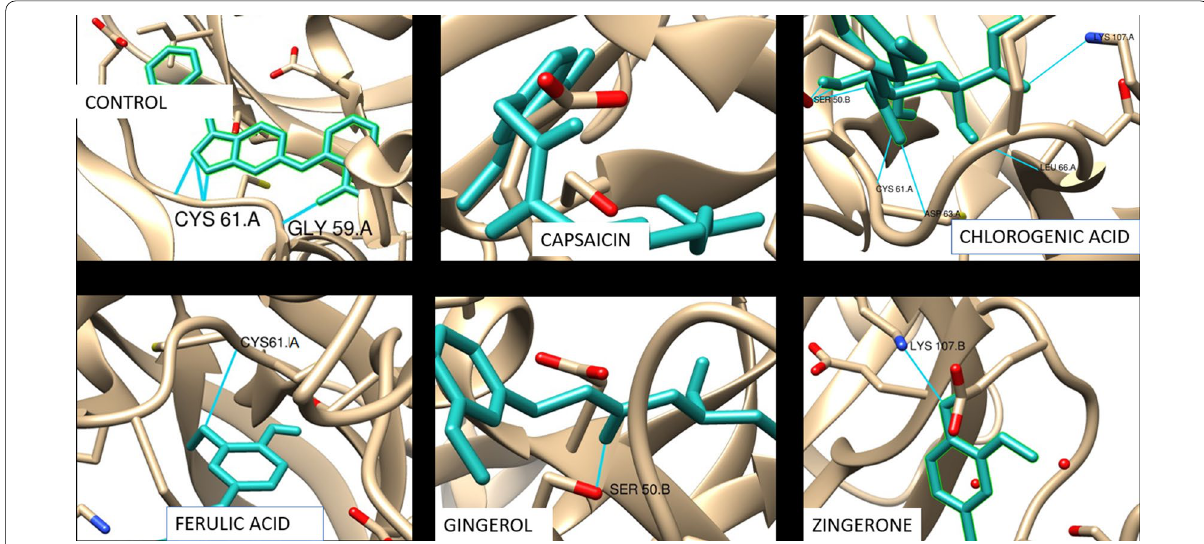
Fig. 5 Docked pictures of curcumin analogues and axitinib (control) against VEGF receptor. (Ligand represents the blue sticks, hydrogen bond interaction is represented in blue line, and receptor is represented in solid white ribbon